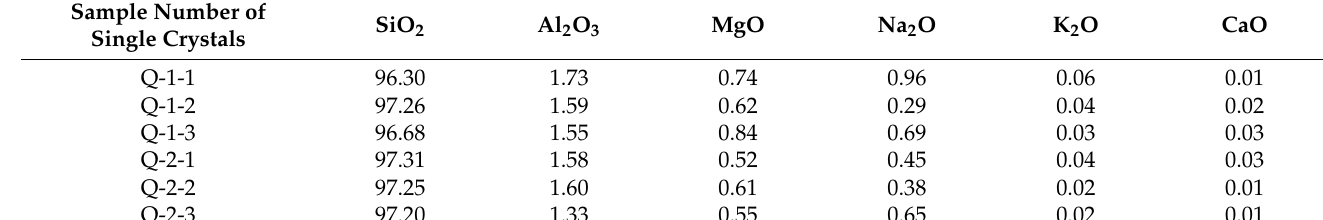
Table 2. Chemical composition of investigated regrown quartz crystal samples (wt%).